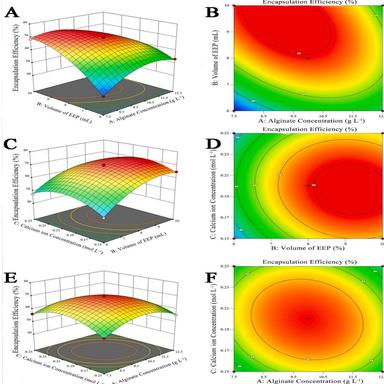
Response surface diagrams and contour maps for the optimization of PM by the theoretical response surface models. Factor: A, alginate concentration. B, volume of EEP. C, calcium ion concentration.